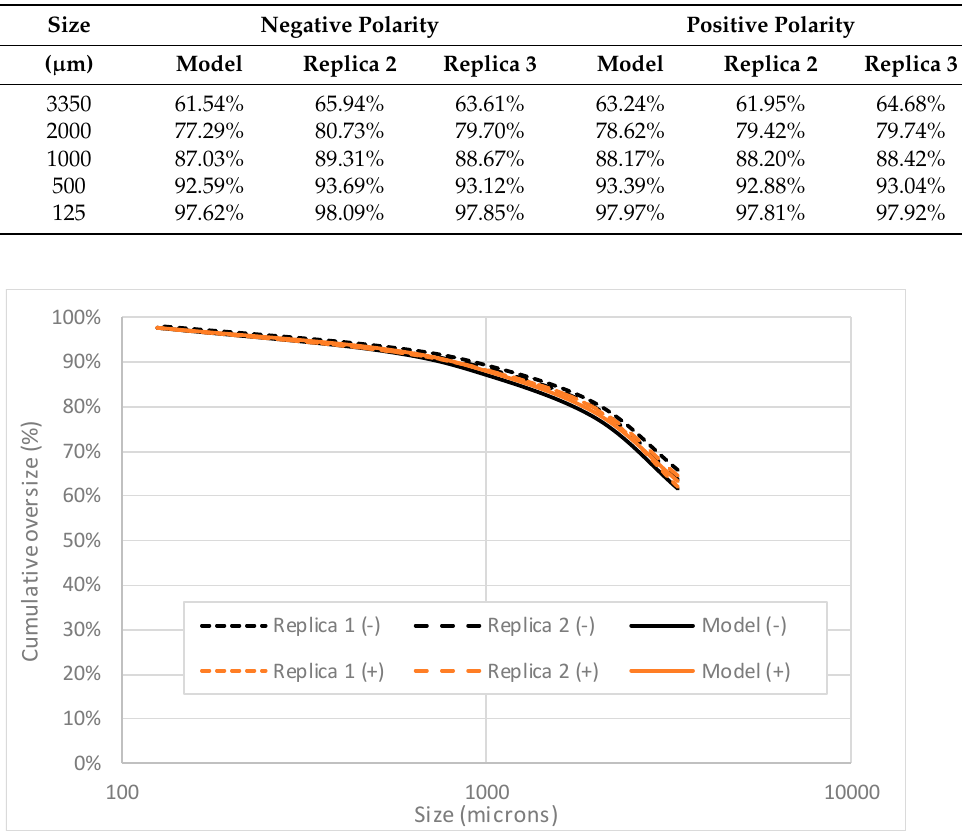
Table 6. F-test values obtained in the comparisons performed.